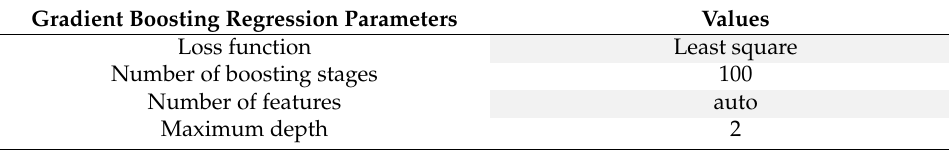
Table A4. Optimized hyperparameters of gradient boosting regression